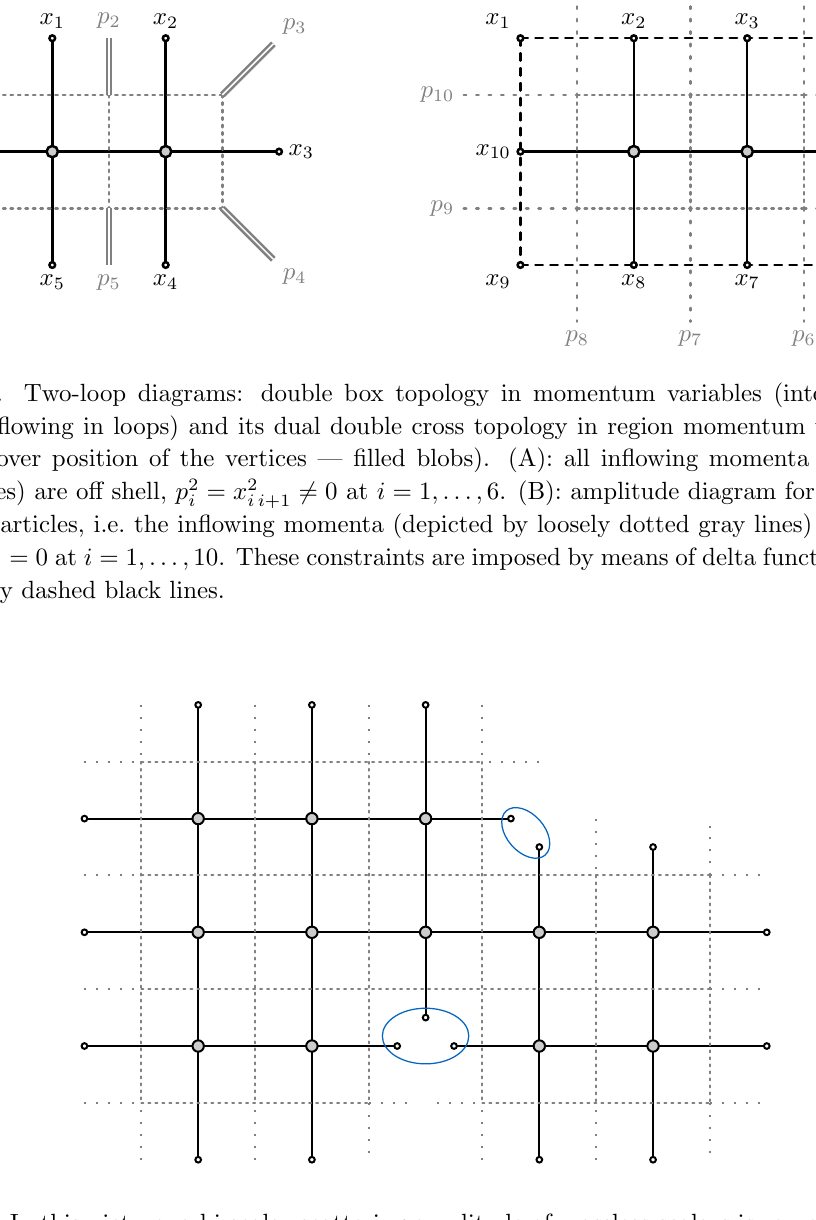
Figure 5 . In this picture, a bi-scalar scattering amplitude of massless scalars is represented in the dual graph depicted by dotted lines. It has doubled (w.r.t. the previous (cid:12)gure 2) external legs at the convex corners of the boundary, and no legs at the concave corners. The corresponding additional momentum variables at convex corners should satisfy the momentum conservation condition at each dual vertex. We obtain the admissible bi-scalar amplitude by identifying the points of the boundary of the original graph which end in the same square (i.e., the same site of the original lattice. Such points are surrounded by ellipses in the above (cid:12)gure. The masslessness is ensured by additional factors (cid:14) ( p 2 ) multiplying the external legs of the dual graph. j